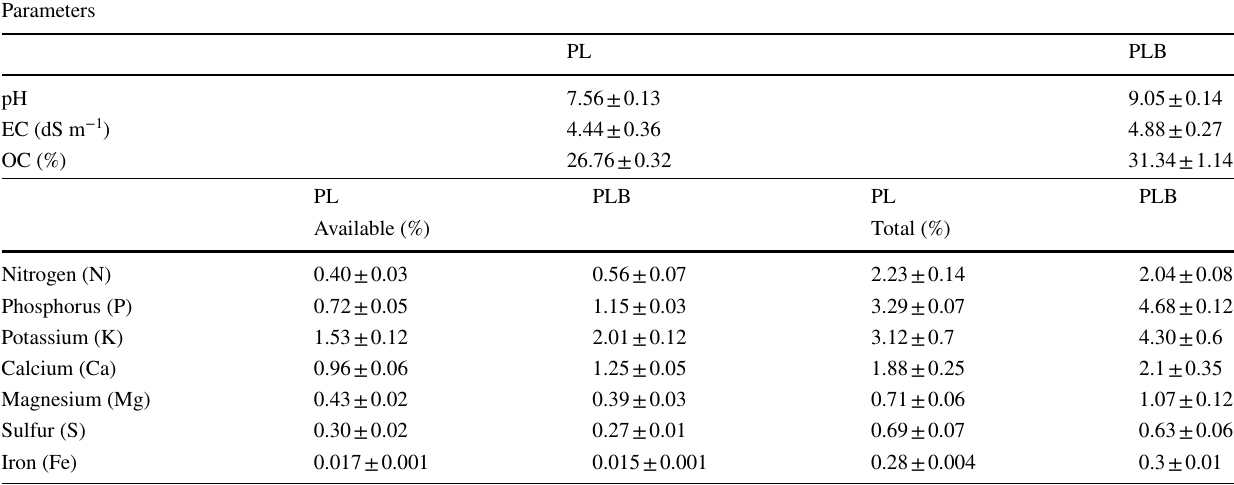
Table 2 Properties of poultry litter and poultry litter biochar